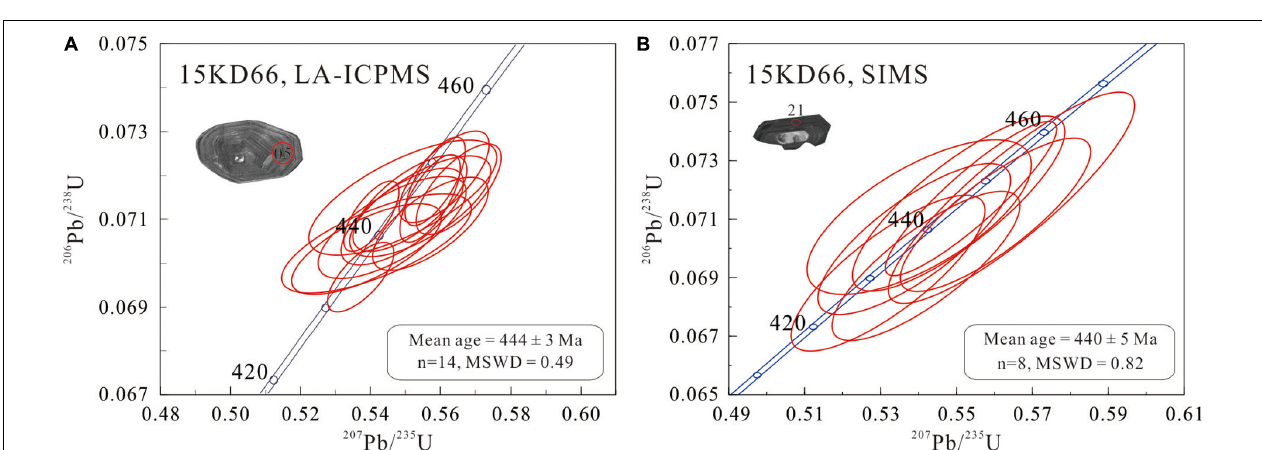
FIGURE 6 | U–Pb age Concordia plots for sample 15KD66, obtained by LA-ICPMS (A) and SIMS (B) , respectively. Typical zircon cathodoluminescence (CL) images are also shown (the circle for LA-ICPMS dating is 30 µ m, for SIMS dating is 10 µ m).